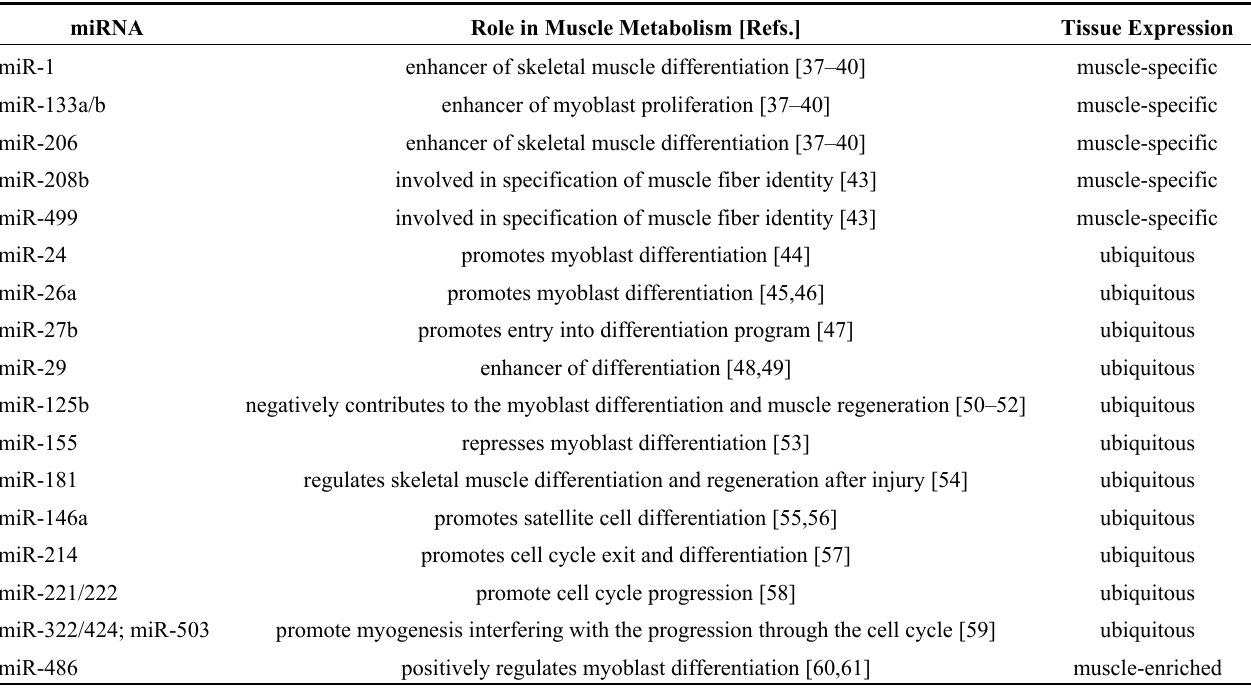
Table 1. miRNAs expressed in muscular tissue (in an exclusive manner or not) and their global effect on muscle